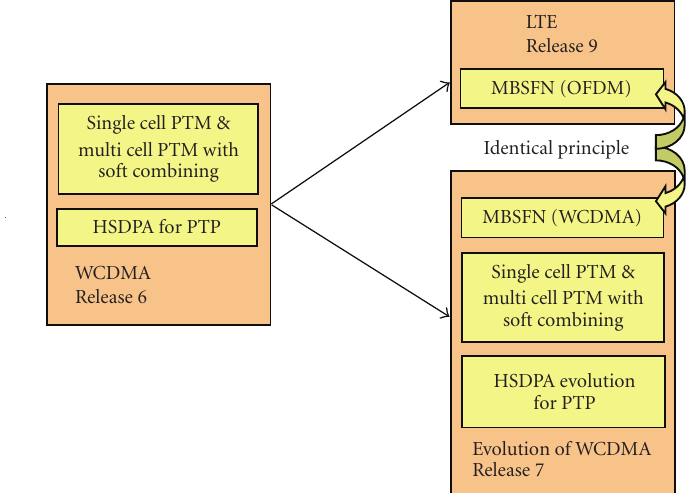
Figure 16: MBMS evolution tracks. Releases refer to 3GPP